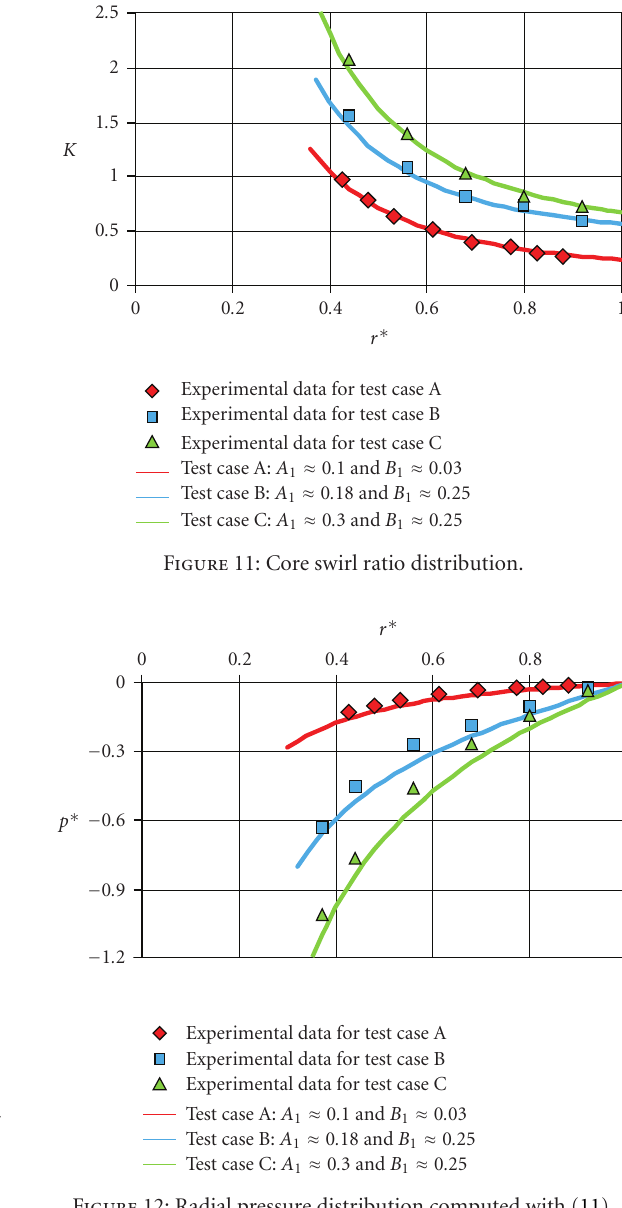
Figure 12: Radial pressure distribution computed with